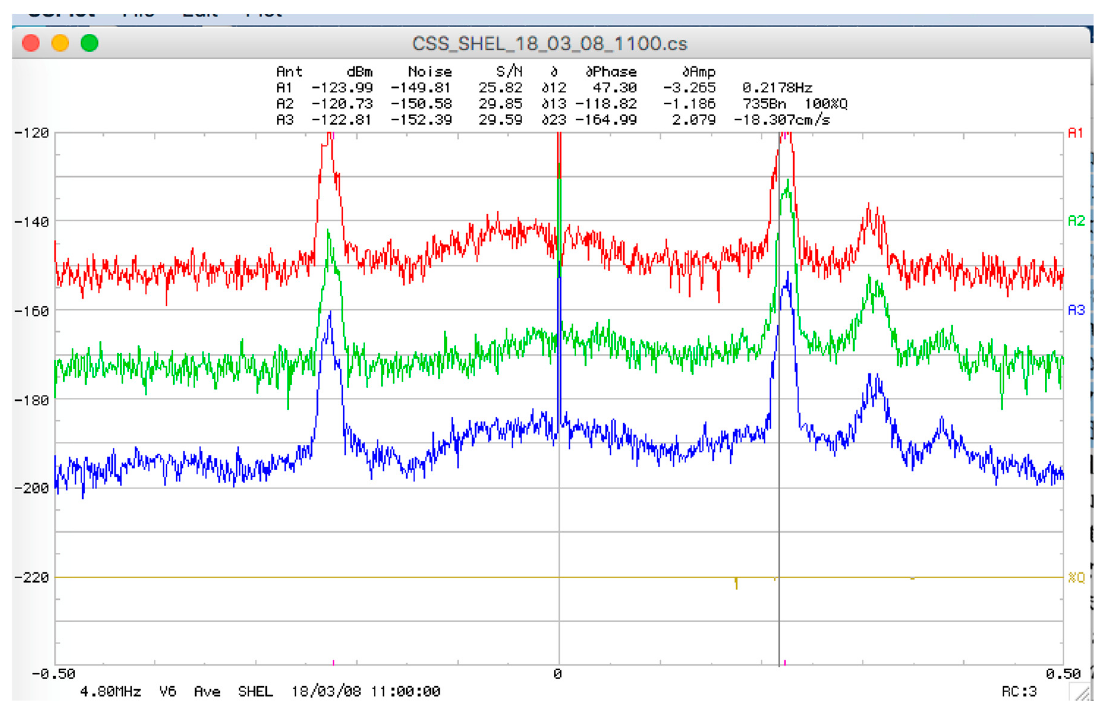
Figure 1. An example of an uncontaminated radar spectrum obtained from a SeaSonde system, measured at Shelter Cove, California, 8 March, 2018, 11a.m. range 18 km. Radar-echo spectral power (dB) from the three SeaSonde antennas is plotted vs. Doppler frequency for the Loop 1 antenna (A1, red), the Loop 2 antenna (A2, green) and the monopole (A3, blue). The curves are offset by 20 dB for better visibility. The first-order Bragg peaks at Doppler ± 0.22 Hz are surrounded by second-order echo, with the second-order peak especially visible to the right of the positive Bragg peak. The yellow line is an indicator of spectral quality.